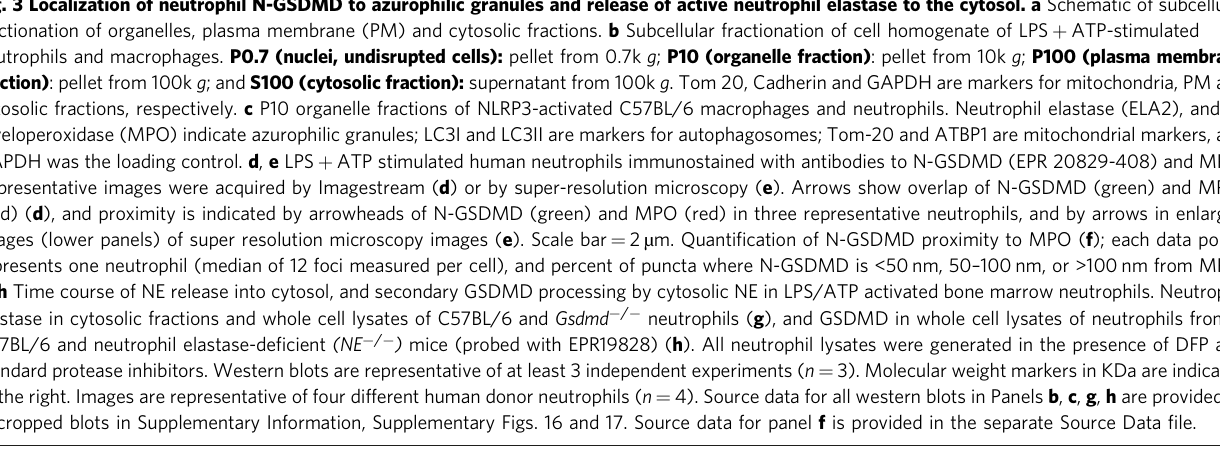
Fig. 3 Localization of neutrophil N-GSDMD to azurophilic granules and release of active neutrophil elastase to the cytosol. a Schematic of subcellular fractionation of organelles, plasma membrane (PM) and cytosolic fractions. b Subcellular fractionation of cell homogenate of LPS + ATP-stimulated neutrophils and macrophages. P0.7 (nuclei, undisrupted cells): pellet from 0.7k g ; P10 (organelle fraction) : pellet from 10k g ; P100 (plasma membrane fraction) : pellet from 100k g ; and S100 (cytosolic fraction): supernatant from 100k g . Tom 20, Cadherin and GAPDH are markers for mitochondria, PM and cytosolic fractions, respectively. c P10 organelle fractions of NLRP3-activated C57BL/6 macrophages and neutrophils. Neutrophil elastase (ELA2),